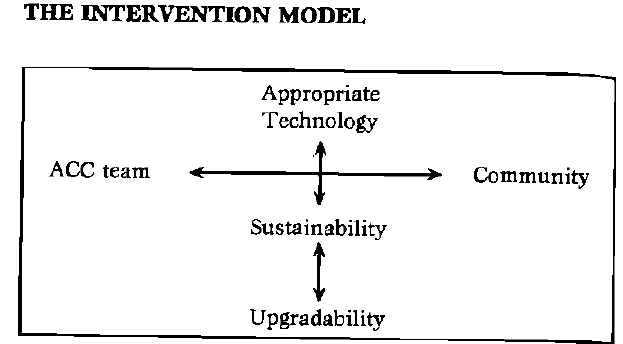
Figure 1: AAC intervention model (adapted from Emmett et al.,